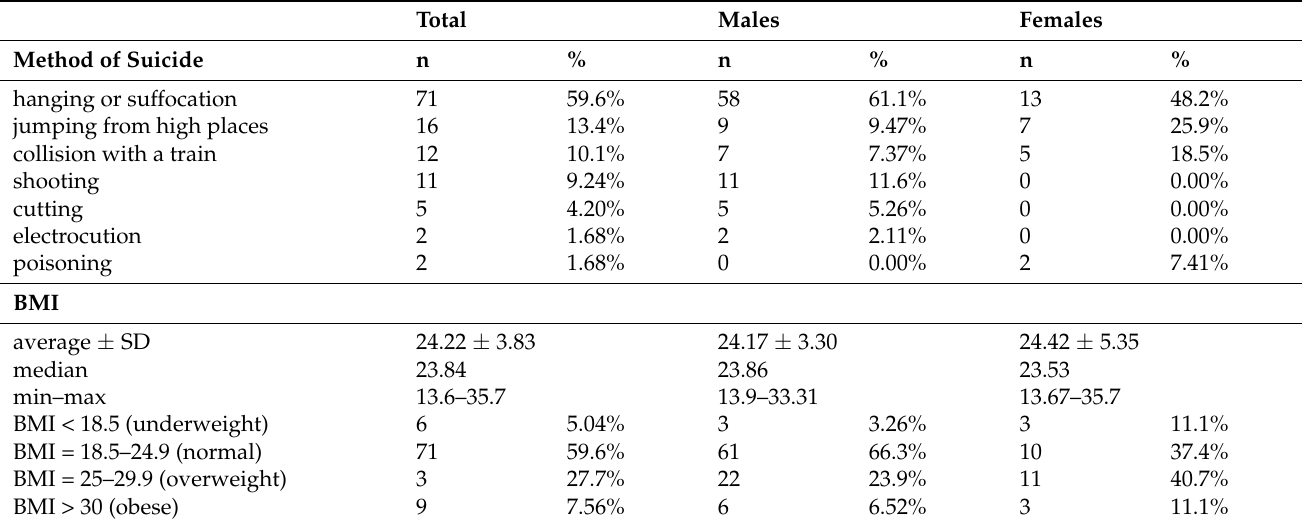
Table 3. Methods of suicide and BMI in suicide